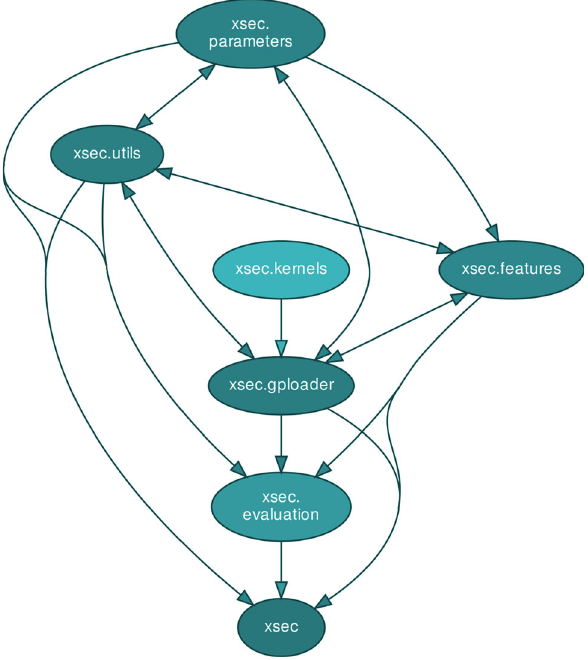
Fig. 23 Module dependency graph of